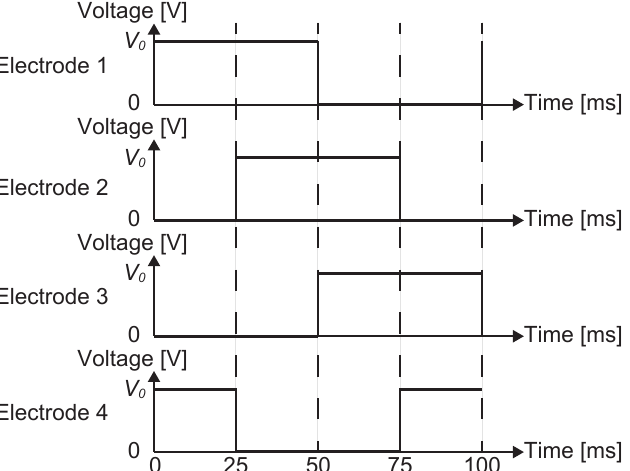
Figure 6. The voltage patterns applied to stator electrodes. Each pattern is a pulse wave with a 50% duty ratio. Voltage shift occurs every 25 ms in two of the four patterns. The voltage for “Electrode 2” is applied to the electrodes belonging to the second phase, except the sensing electrode.